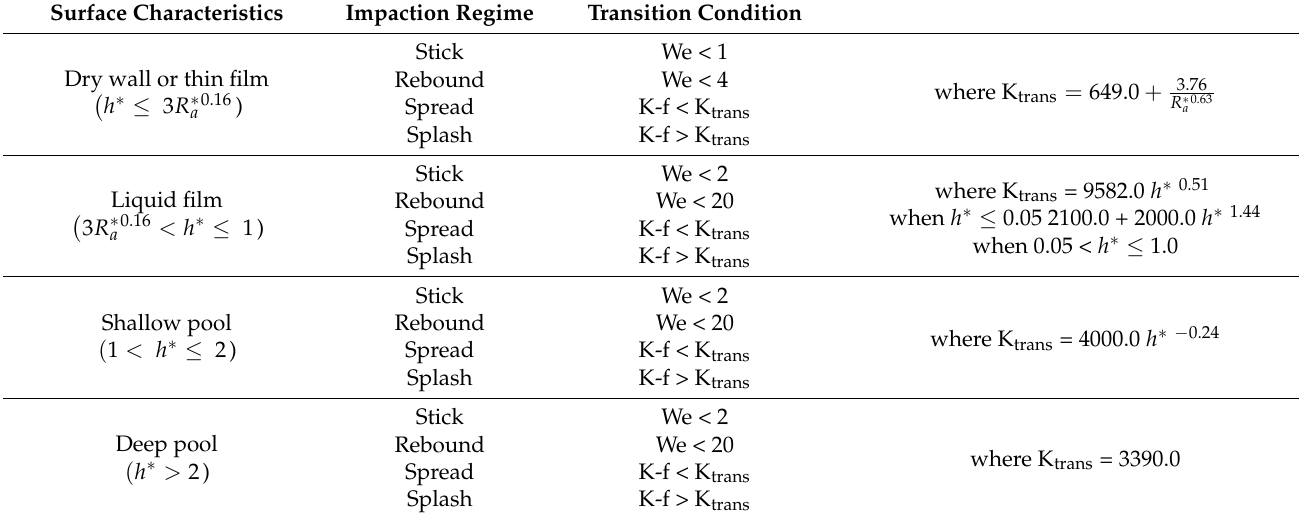
Table 1. Spray–wall interaction (SWI) model: transition criteria for impaction regimes based on surface